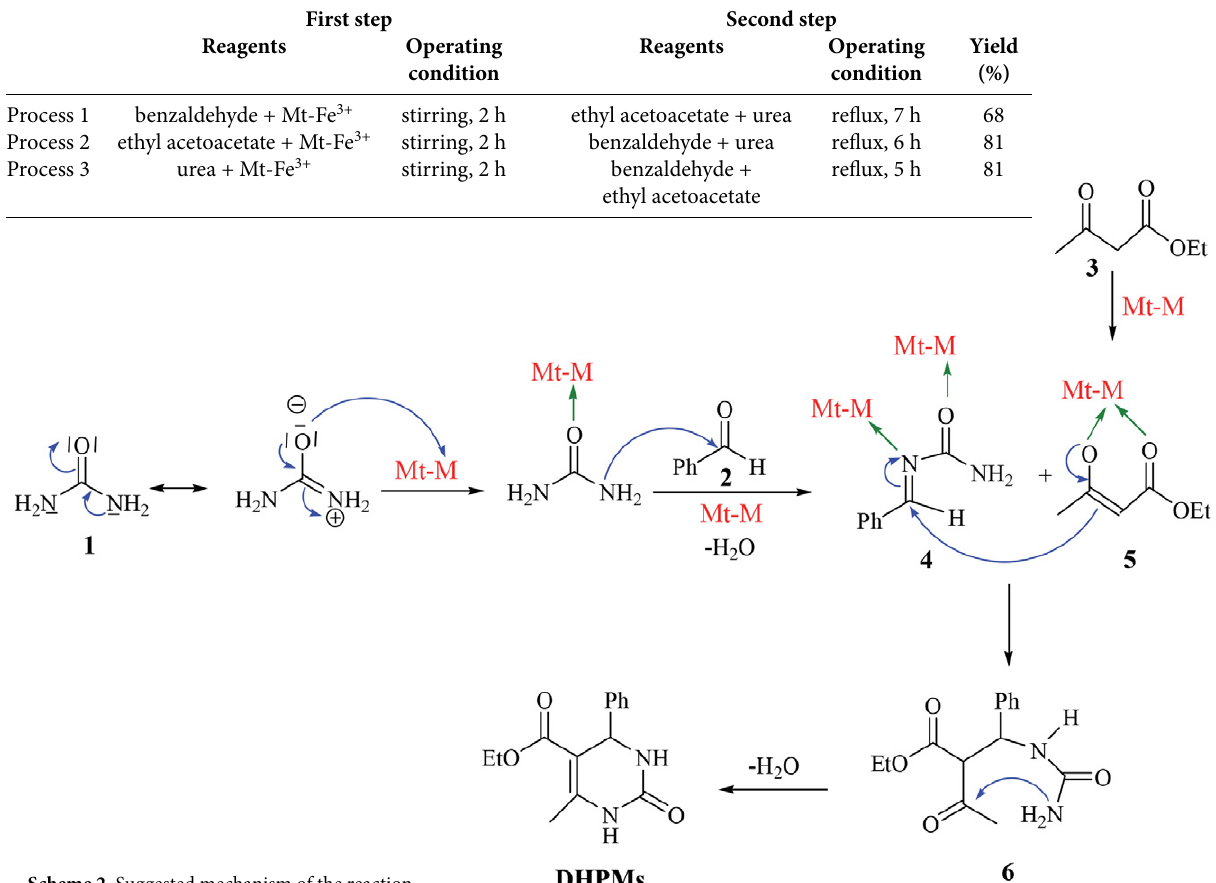
Table 6. Effect of introduction order of